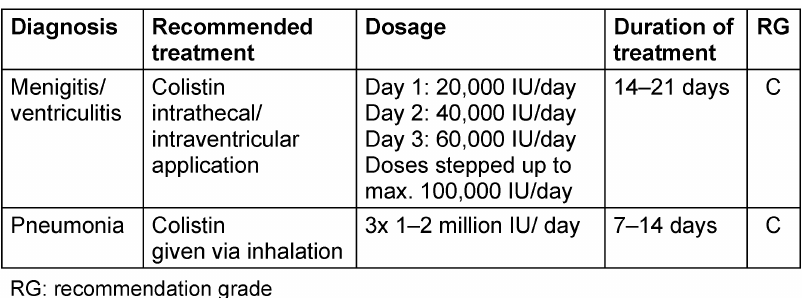
Table 5: Special application forms of